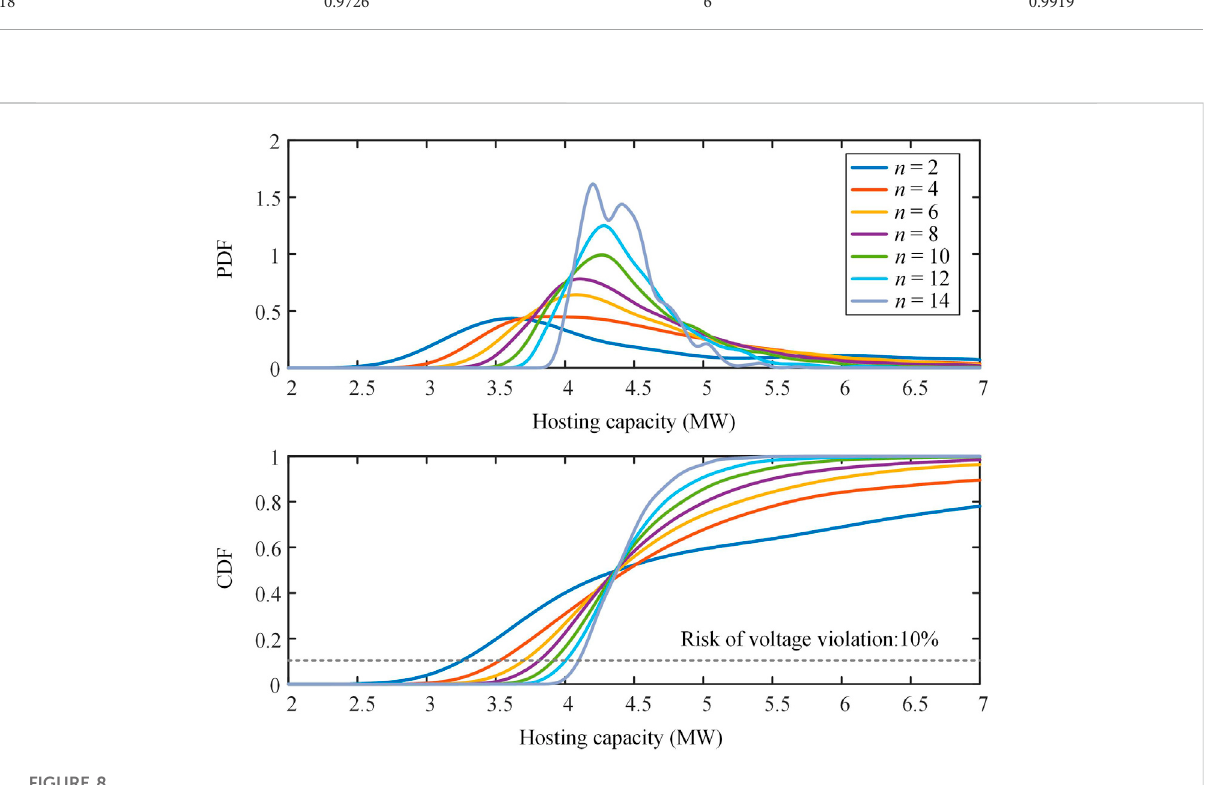
FIGURE 8 PDF and CDF of DG hosting capacity at PF =